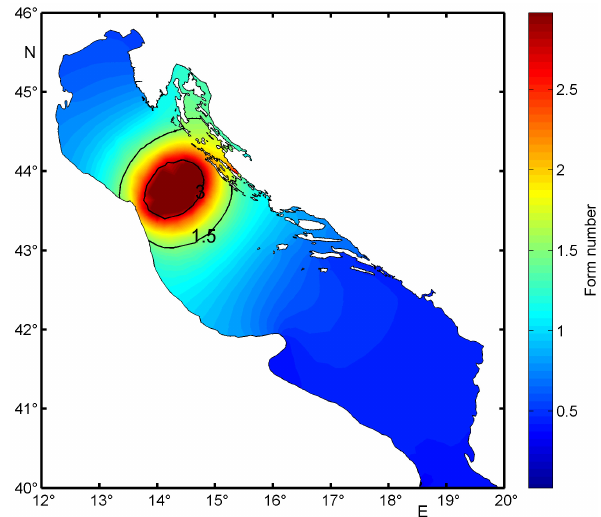
Fig. 7. Form number for the Adriatic Sea calculated from modelled diurnal (K1+O1) and semidiurnal (M2+S2)